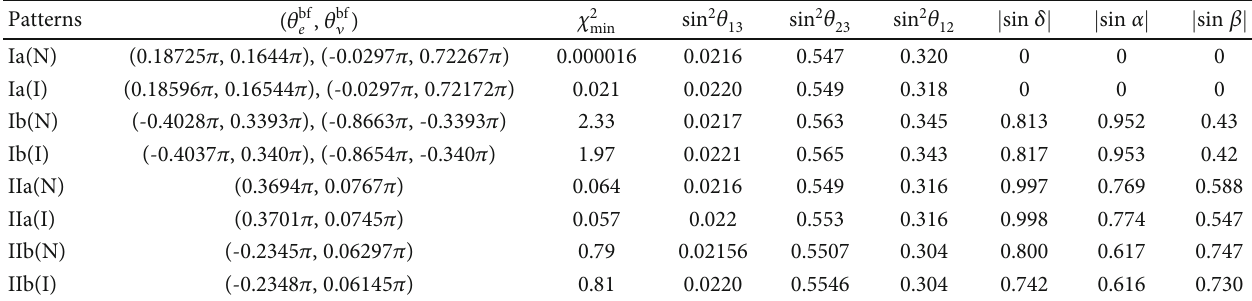
Table 2: Best fi t data of lepton mixing angles and CP phases. “ N ” and “ I ” denote the normal ordering of neutrino masses and the inverted ordering,